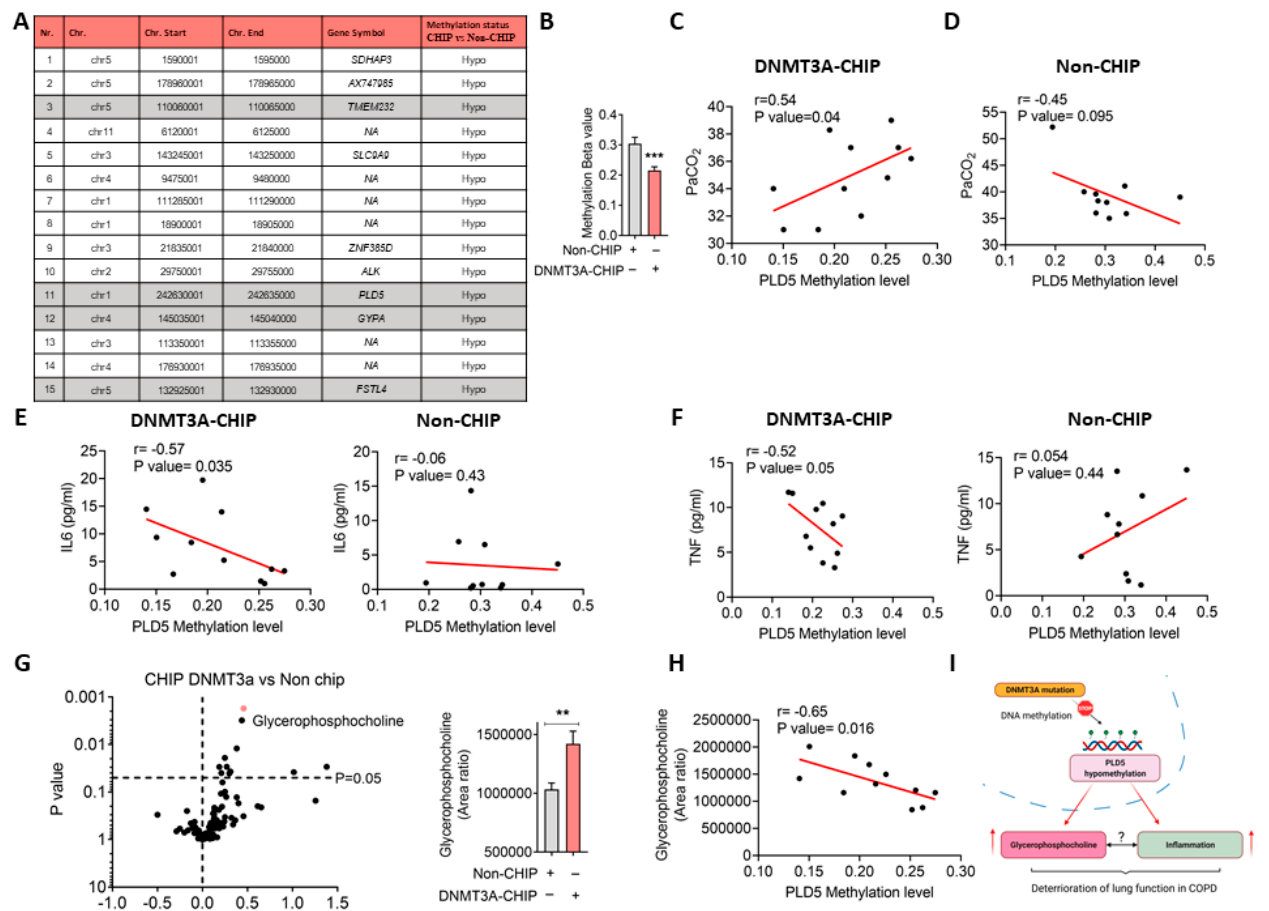
Figure 2. PLD5 gene methylation association with pro-inflammatory signaling and impaired lung function in early COPD. ( A ) Characteristics of top 15 differentially methylated tiling sites between DNMT3A-CHIP and Non-CHIP patients. ( B ) Methylation level of tiling-associated PDL5 between DNMT3A-CHIP and Non-CHIP patients, ***: p < 0.001, 2-tailed Student’s t test. ( C , D ) Pearson correlation analysis between PLD5 methylation and PaCO 2 level in DNMT3A-CHIP (N = 11) and Non-CHIP (N = 10) patients. ( E ) Pearson correlation analysis between PLD5 methylation and plasma IL6 concentration in DNMT3A-CHIP (N = 11) and Non-CHIP (N = 10) patients. ( F ) Pearson correlation analysis between PLD5 methylation and plasma TNF concentration in DNMT3A-CHIP (N = 11) and Non-CHIP (N = 10) patients. ( G ) Volcano plot of metabolome analysis of serum in DNMT3A- CHIP (N = 18) and Non-CHIP (N = 22) patients. **: p < 0.01, 2-tailed Student’s t test ( H ) Pearson correlation analysis between PLD5 methylation and serum glycerolphosphocholine concentration in DNMT3A-CHIP (N = 11). ( I ) Schematic diagram displaying the link between DNMT3A dysfunction and enhancement of metabolic and pro-inflammatory responses in COPD.